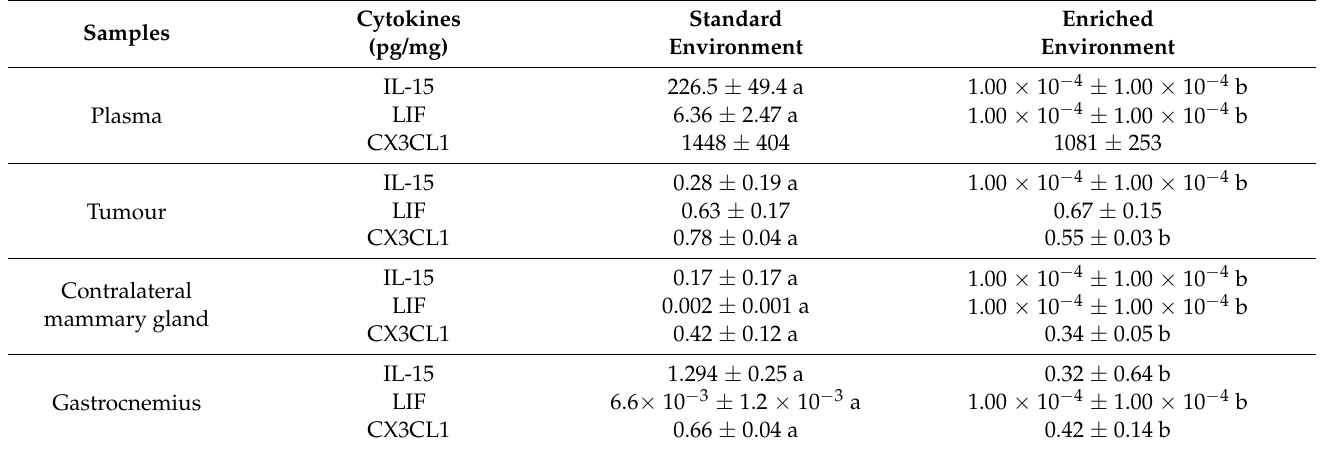
Figure 2. The enriched environment modifies myokine secretions like imposed physical activity. ( A ) Plasma myostatin concentration. ( B ) Plasma irisin concentration. ( C ) Plasma IL-6 concentration. ( D ) Quantity of IL-10 in gastrocnemius. ( E ) Ratio of IL-6/IL-10 in gastrocnemius. ( F ) Quantity of IL-1 α in gastrocnemius. Results are in pg/mg of tissue and mean ± SEM ( n = 5 mice muscle or plasma samples/group). Data were analysed by Mann–Whitney t -test. Representative data are shown: * p < 0.05, ** p < 0.01, SE vs. EE. Table 1. Tissue cytokine